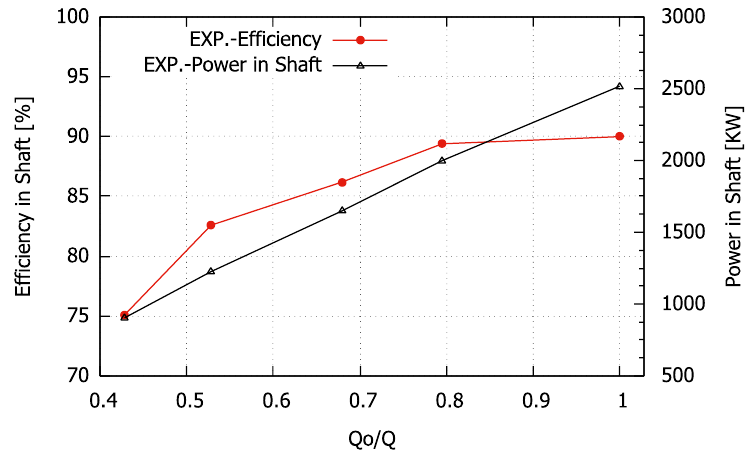
Figure 9. Effiency and power vs. partial flow rate.